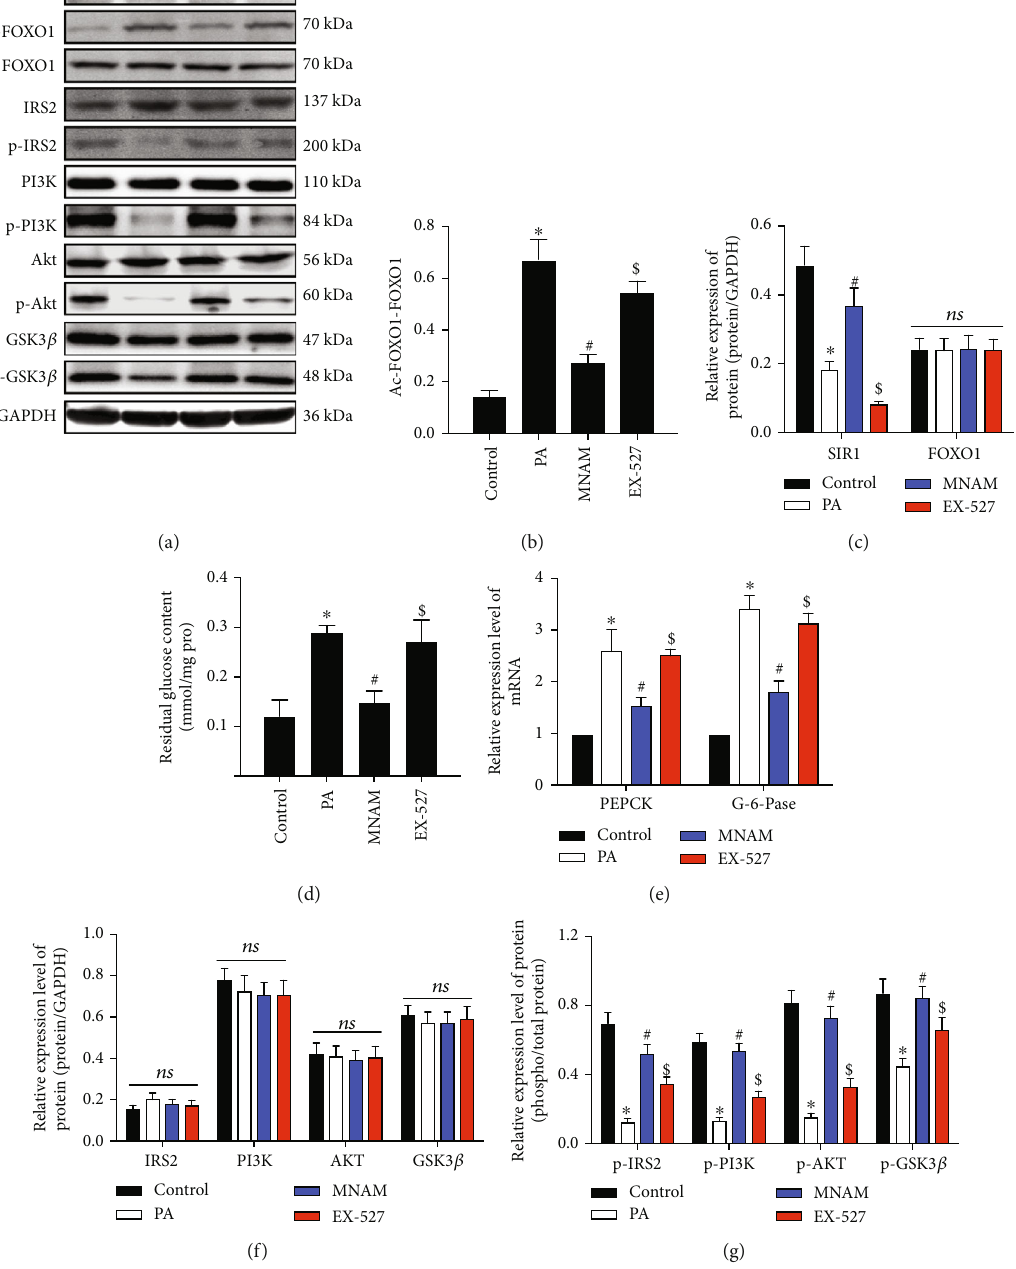
Figure 7: MNAM regulates hepatocyte insulin sensitivity via activation of SIRT1. (a)The result of Western blots ( n = 3 ); (b) bar graphs of acetylation of FOXO1; (c) bar graphs of SIRT1 and FOXO1; (d) glucose residual amounts; (e) real-time PCR data used to detect mRNA expression of Pepck and G-6-Pase in cells from each group; (f) bar graphs of IRS2, PI3K, AKT, and GSK3 β ; (g) bar graphs of p-IRS2/IRS2, p-PI3K/PI3K, p-AKT/AKT, and p-GSK3 β /GSK3 β . ∗ P < 0 : 05 , compared with the control group; # P < 0 : 05 , compared with the PA group; $